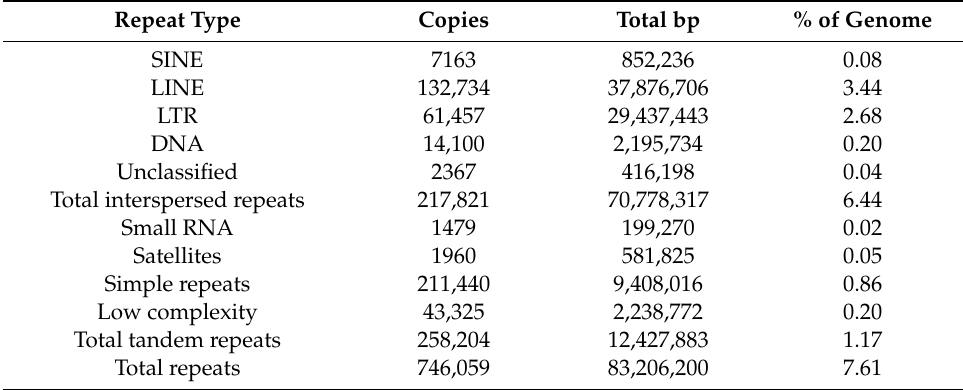
Figure 2. Comparison of transposable element landscapes for the genome of blue-capped cordon-bleu, representing di ff erent levels of e ff ort in transposon annotation. Percentage of bp occupied in the genome is plotted against the Kimura 2-parameter (transitions / transversions) distance of each transposable element (TE) copy from its consensus. Panel ( a ) shows the landscape for when avian repeats available in Repbase ( Aves Repbase, A R) and collared flycatcher (CF) repeats were used for masking the genome. Panel ( b ) is based on de-novo predicted repeats from Repeatmodeler, A R and CF repeats. Note the share of unknown (grey) repeats, a majority of which were identified as solo-long terminal repeats (LTRs) of endogenous retrovirus (ERV)-like retrotransposons when manually curated ( c ). The pie chart specifies the relative abundance of di ff erent TEs based on the .tbl file of the RepeatMasker output (Table 2), for the curated, final landscape ( c ). Table 2. Copy number, total base pair and density of di ff erent classes of repetitive elements annotated by RepeatMasker using a library consisting of manually curated blue-capped cordon-bleu and collared flycatcher repeats, and the Aves library from